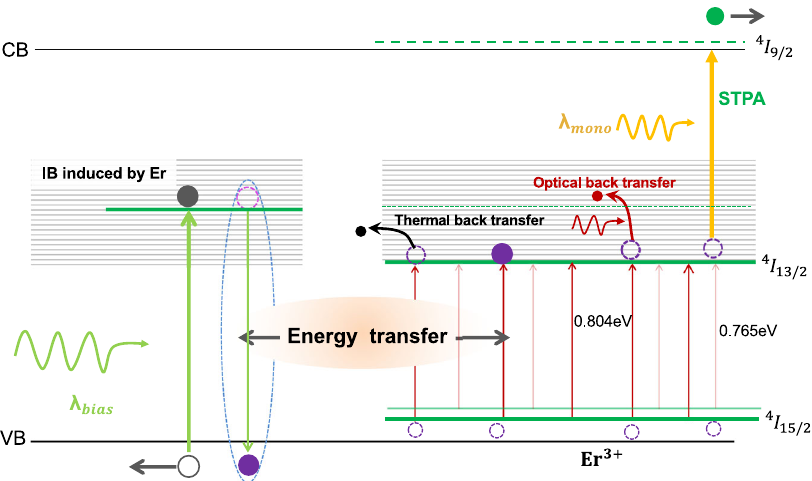
Fig. 7 Operating principle of the Er:GaAs energy-transfer ratchet IBSC (ETR-IBSC) device. First, a sub-bandgap photon excites an electron from the valence band (VB) to the intermediate band (IB) induced by Er doping. The recombination of this carrier generates an electron at the 4 I 13/2 state via an energy transfer. This carrier may be transferred back to the IB via thermal activation or optical excitation. In the sequential two-photon absorption (STPA) process, which is required for the additional current generation in the ETR-IBSC, an additional sub-bandgap photon excites the electron at the 4 I 13/2 state to the conduction band